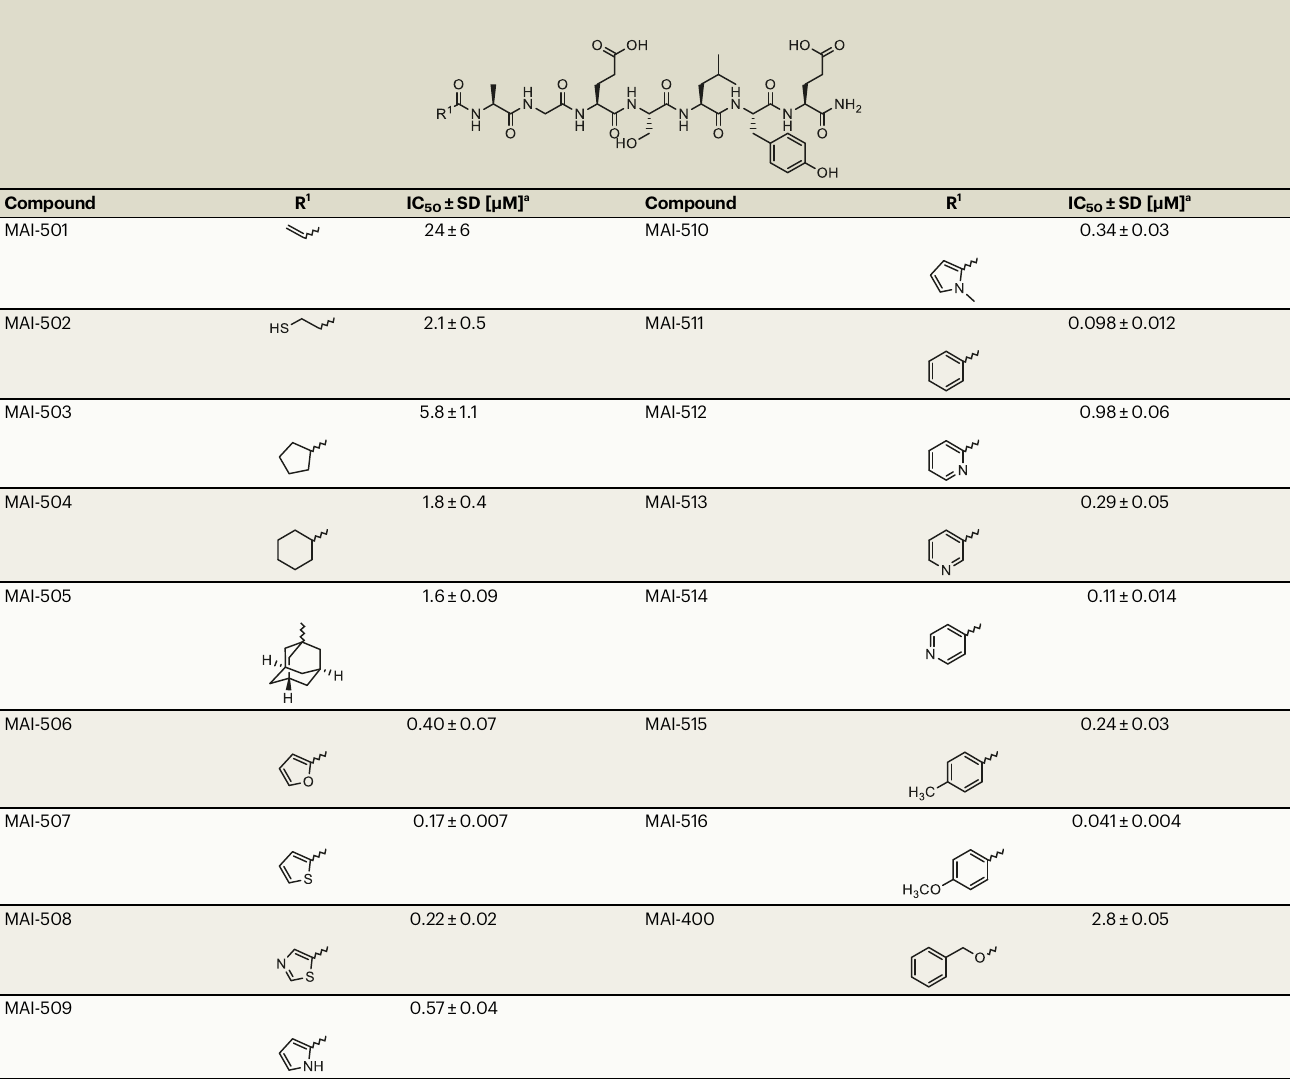
Table 3 | Peptide inhibitor MAI-501 – MAI-516 structures and APC binding af fi nities as measured by FP-based assays